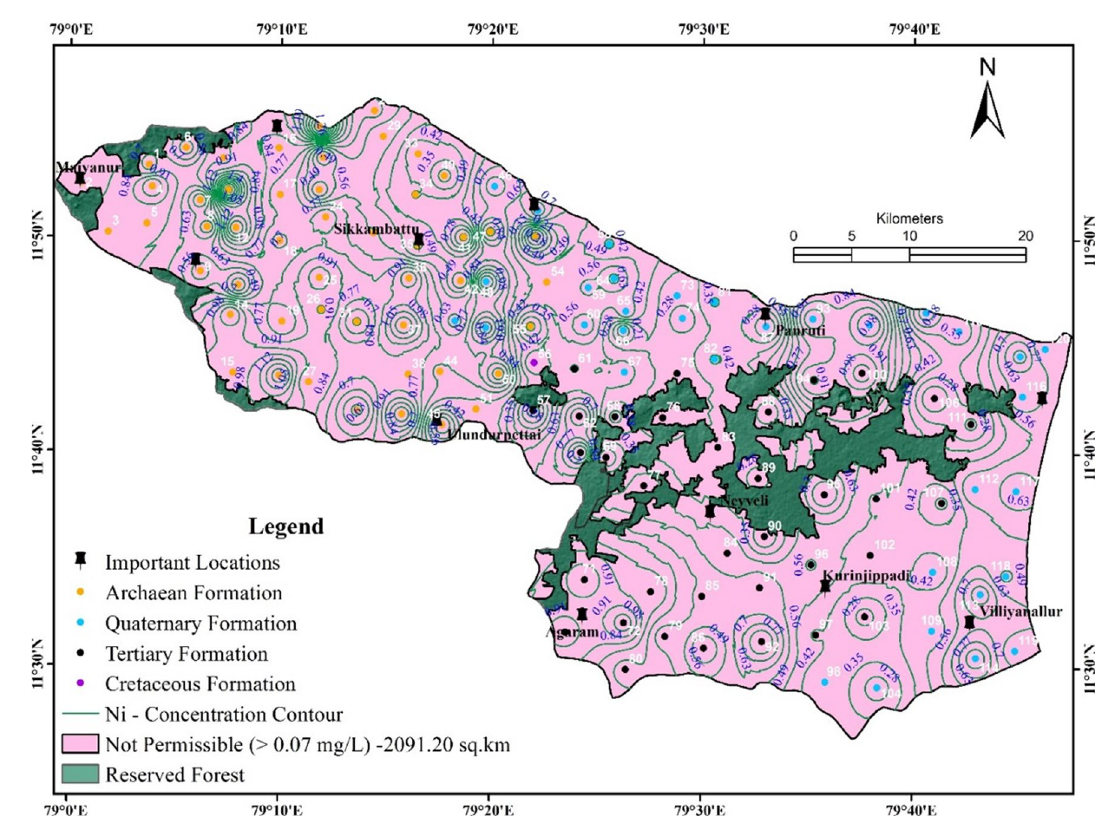
Fig. 13 Spatial variation with contour map of nickel in groundwater Table 2 Correlation analysis of Archaean groundwater samples